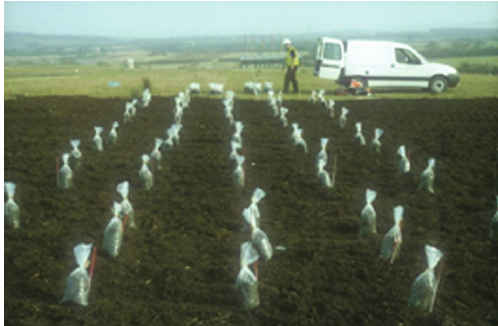
Figure 12: Two litre Earthworm Inoculation Units (EIUs) ready for inoculation into an organically-enriched landfill cap in the south of